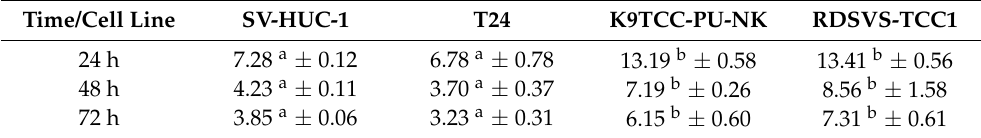
Table 2. Comparison of PR-619 concentrations that inhibited 50% of the cell proliferation (IC 50 values ( µ M)) for all tested cell lines after 24, 48, and 72 h of exposure, evaluated with MTT assay. Time/Cell Line